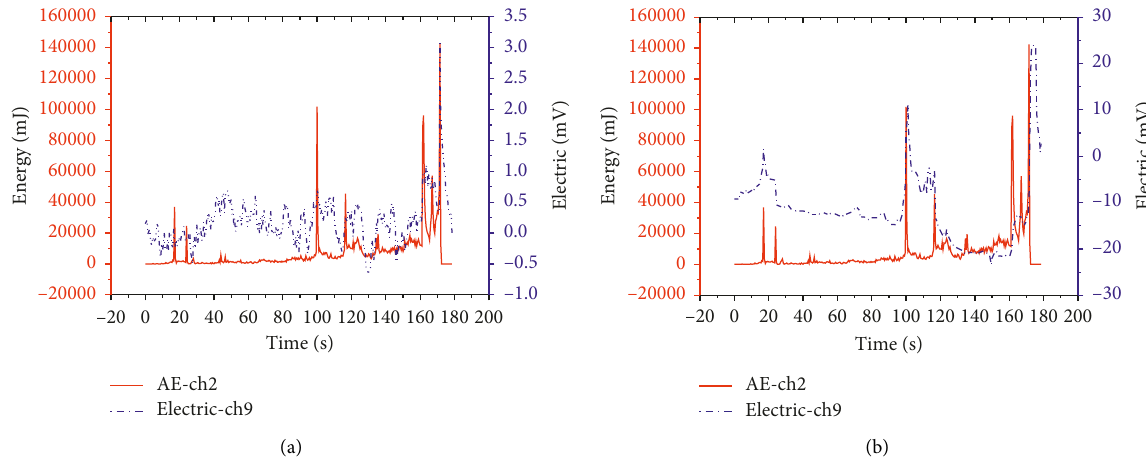
Figure 8: Comparison between AE energy and the electric signals of ch8. (a) Sample 1. (b) Sample 2. Light blue dotted lines and orange arrows indicate abnormal response of signals.